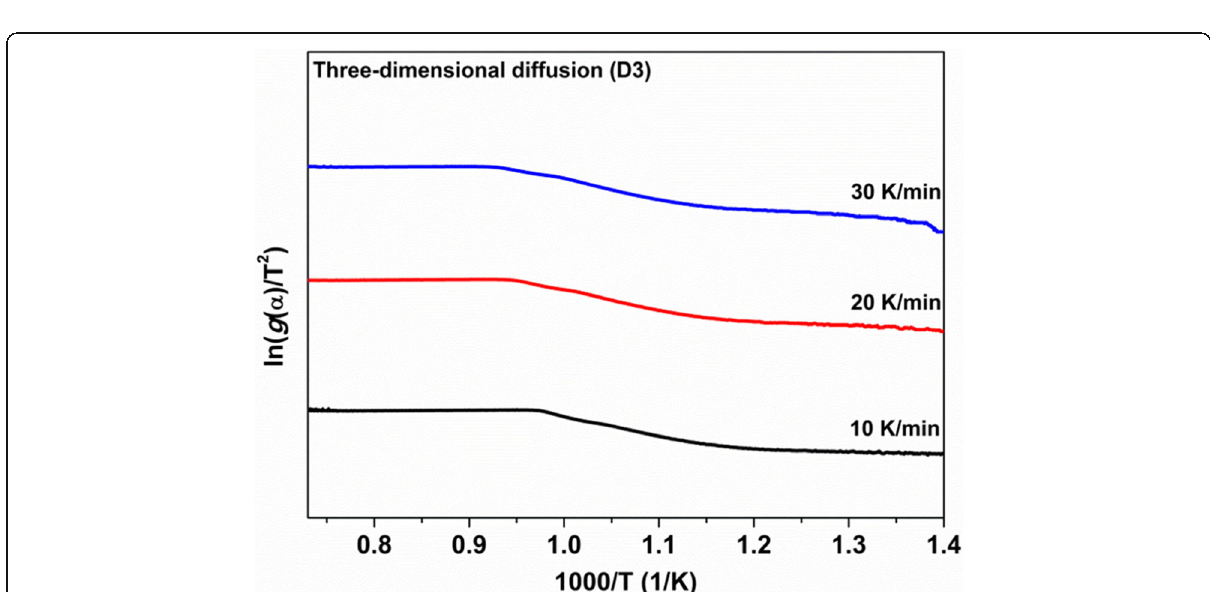
Fig. 8 CR plot for the three-dimensional diffusion (D3) reaction model of the solid-state reaction heated at different heating